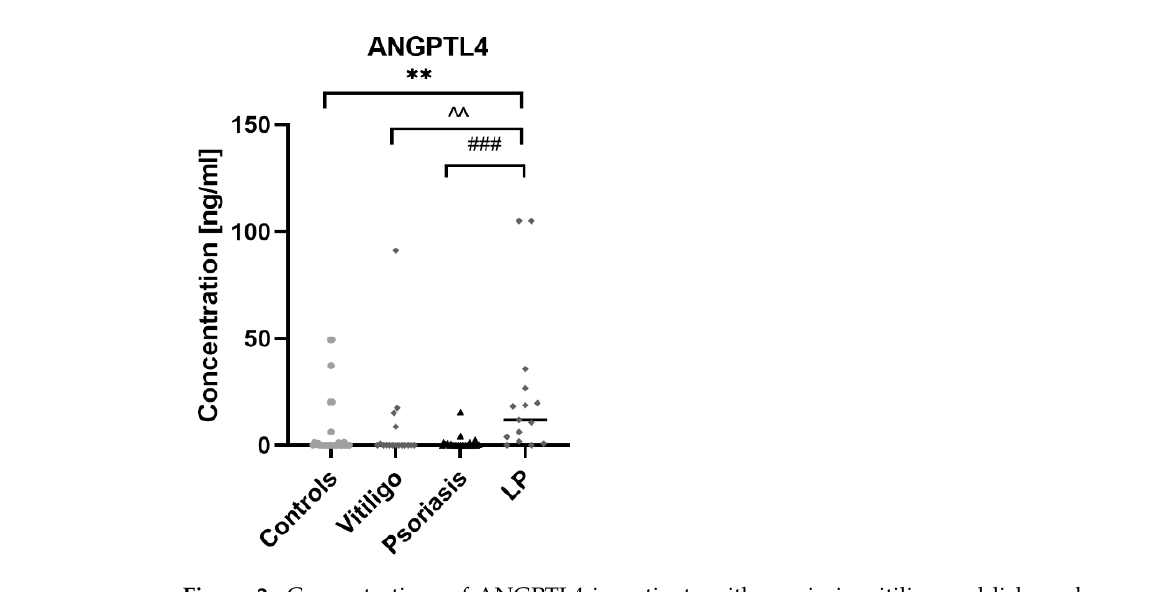
Figure 2. Concentrations of ANGPTL4 in patients with psoriasis, vitiligo and lichen planus, as well as in control group. ** means statistically significant difference between patients with LP and controls with p < 0.01; ˆˆ means statistically significant difference between patients with LP and vitiligo with p < 0.01; ### means statistically significant difference between patients with LP and psoriasis with p < 0.001.